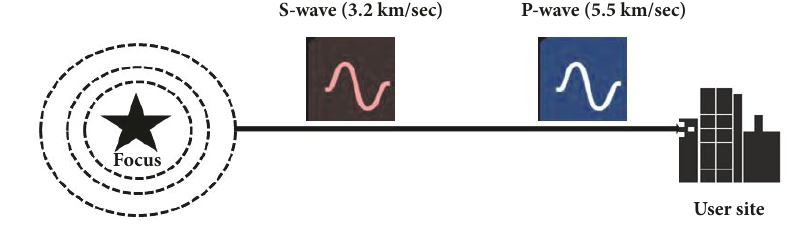
Figure 2: Difference in velocity of P-wave and S-wave used for lead time calculation.